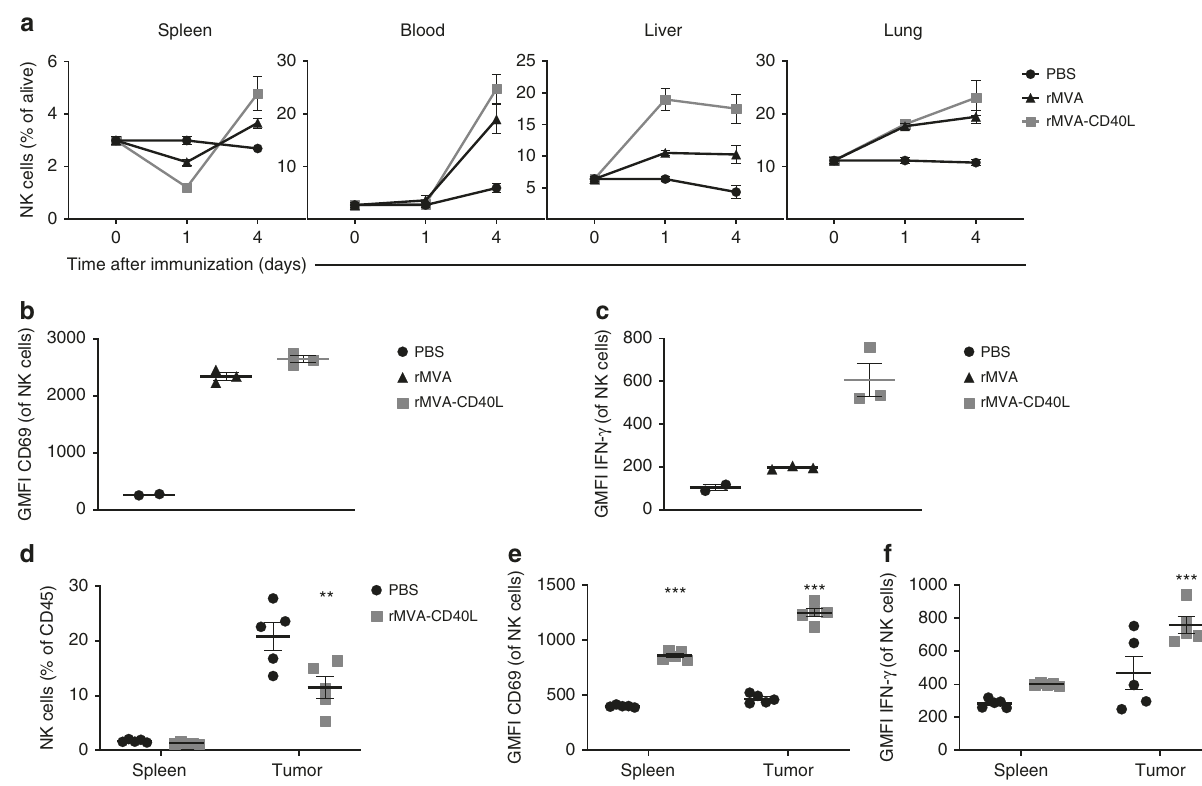
Fig. 4 Strong NK cell activation and functionality upon systemic rMVA-CD40L immunization. a Systemic mobilization of NK cells upon intravenous rMVA immunization. C57BL/6 mice received PBS ( n = 2 mice) or were immunized i.v. with 5 × 10 7 TCID 50 of either rMVA or rMVA-CD40L ( n = 3 mice/group). Mice were killed at days 1 or 4 after immunization and the presence of NK cells (de fi ned as CD3 - NKp46 + cells) in the spleen, blood, liver, and lung was assessed. Data are expressed as mean ± SEM, representative of two independent experiments. b , c rMVA or rMVA-CD40L induction of NK cell activation. C57BL/6 mice received PBS ( n = 2 mice) or were immunized i.v. with 5 × 10 7 TCID 50 of either rMVA or rMVA-CD40L ( n = 3 mice/group). Mice were killed at day 1 after immunization and the expression of CD69 ( b ) and IFN- γ ( c ) on splenic NK cells was analyzed by fl ow cytometry. Data are expressed as mean ± SEM, representative of two independent experiments. d , e Activation of splenic- and tumor-in fi ltrating NK cells upon rMVA-CD40L immunization. B16.OVA tumor-bearing mice ( n = 5 mice/group) received PBS or were immunized i.v. with 5 × 10 7 TCID 50 of rMVA-CD40L. Mice were killed at day